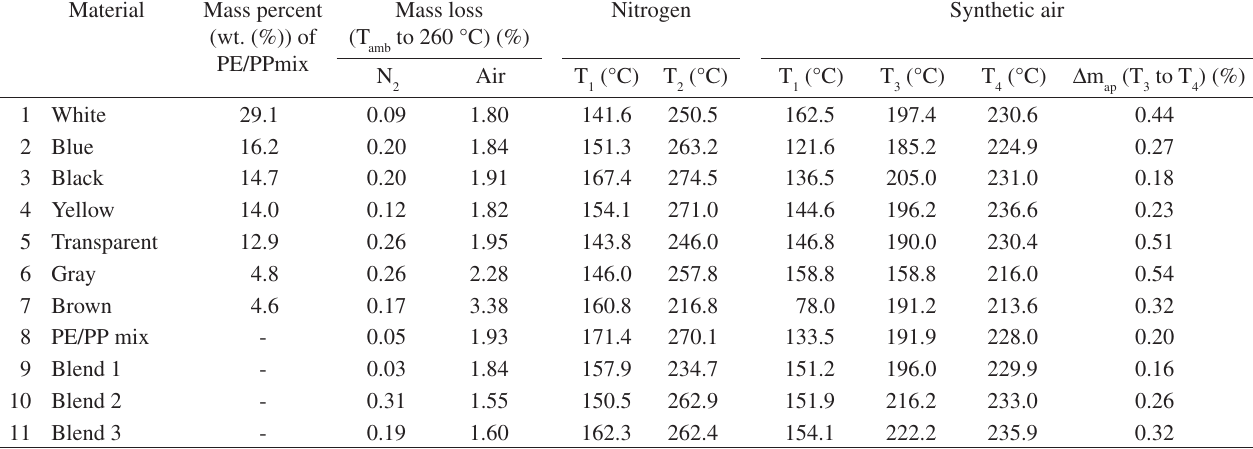
Table 1. Material type, color content, mass loss from temperatures ambient (T atmosphere and T